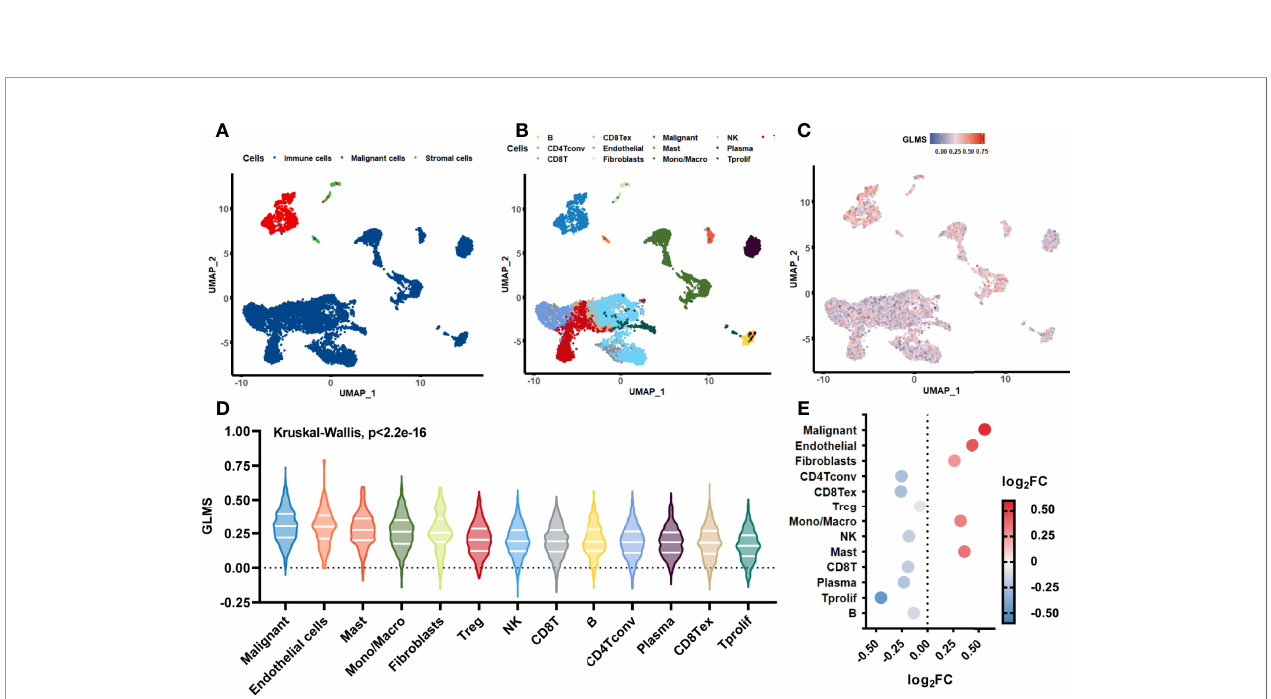
FIGURE 6 | Glycerolipid metabolism score in single-cell datasets. (A, B) The distribution of the cell samples by uniform manifold approximation and projection (UMAP) presented in rough classi fi cation of “ malignant-immune-stromal cells ” (A) and detailed subsets (B) . (C) The UMAP distribution of the cells presented with glycerolipid metabolism scores (GLMS) of each sample. (D) Distribution difference of the GLMS in 13 subsets of cells with statistical analysis by the Kruskal – Wallis test. (E) GLMS enrichment by log2 fold change (log2FC) value in 13 subsets of